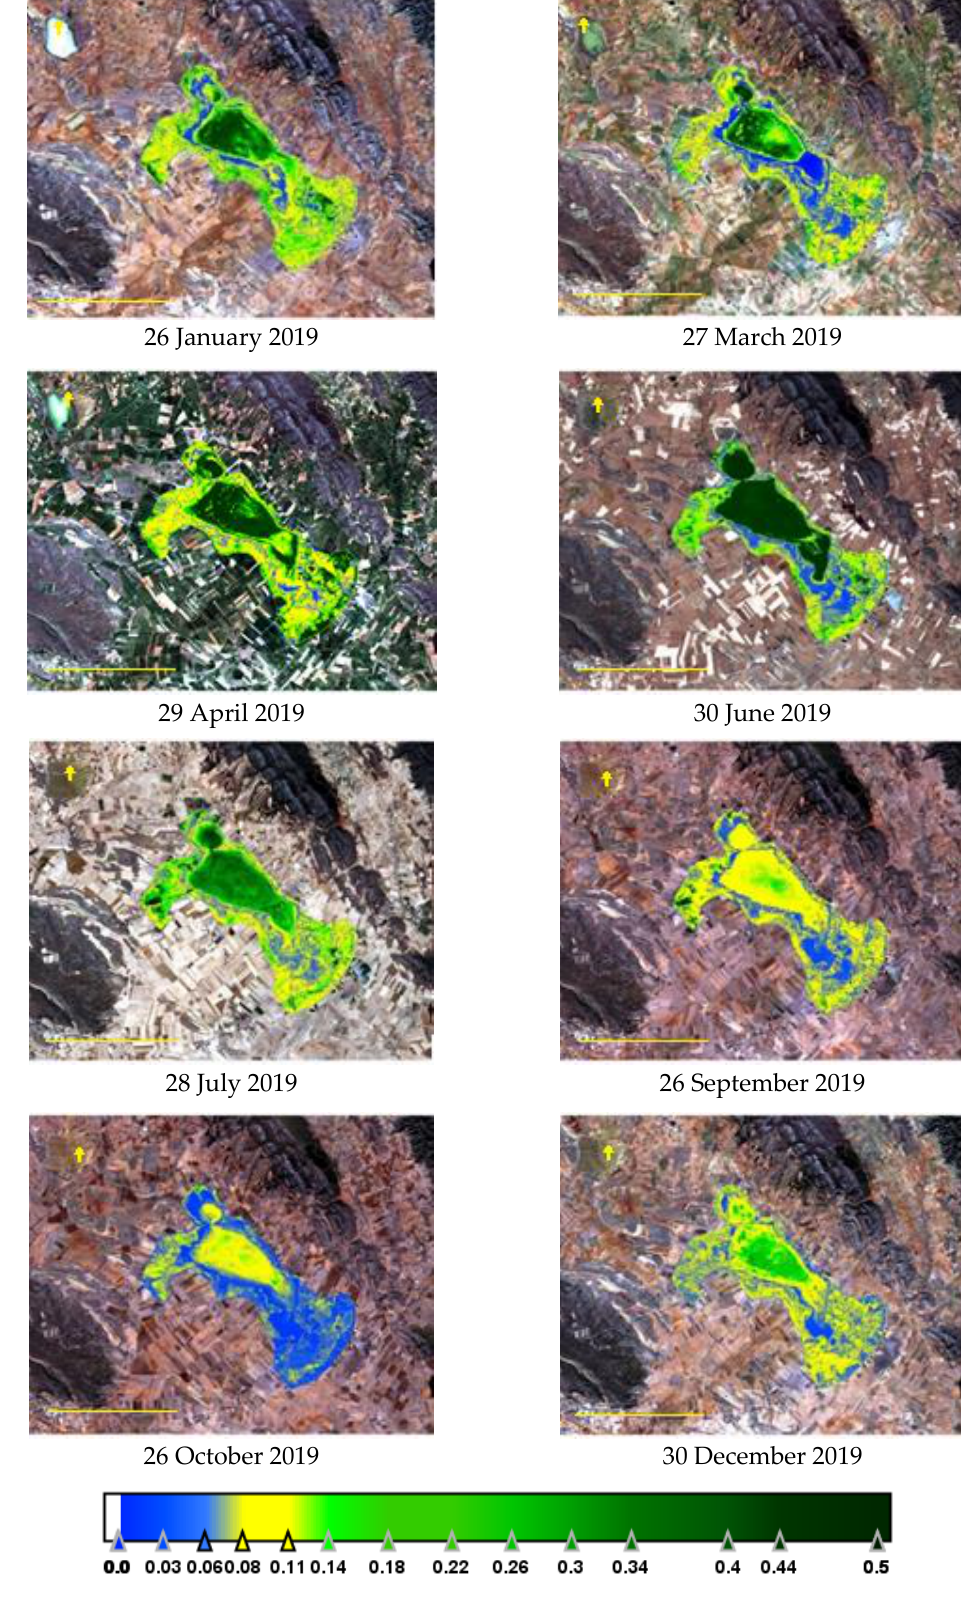
Figure A4. NDI45 evolution during 2019. Scale bar: 5 km.